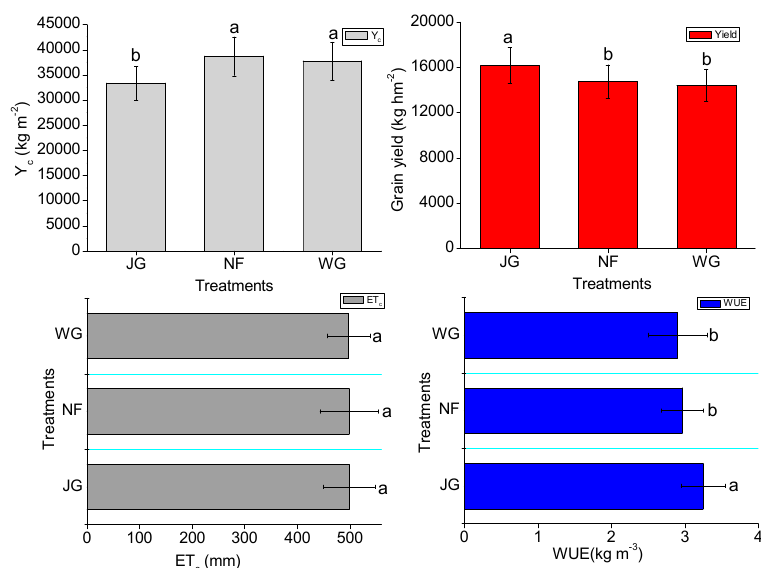
Figure 7. Light and temperature production potential, yield, water use efficiency and water consumption of maize under various mulching patterns. Note: JG represents straw mulching; NF represents organic fertilizer mulching; WG represents no mulching. Y c represents light and temperature production potential; ET c represents water consumption of maize; WUE represents water use efficiency. Bars labeled with different letters (lowercase) differed significantly among the treatments ( p <0.05).